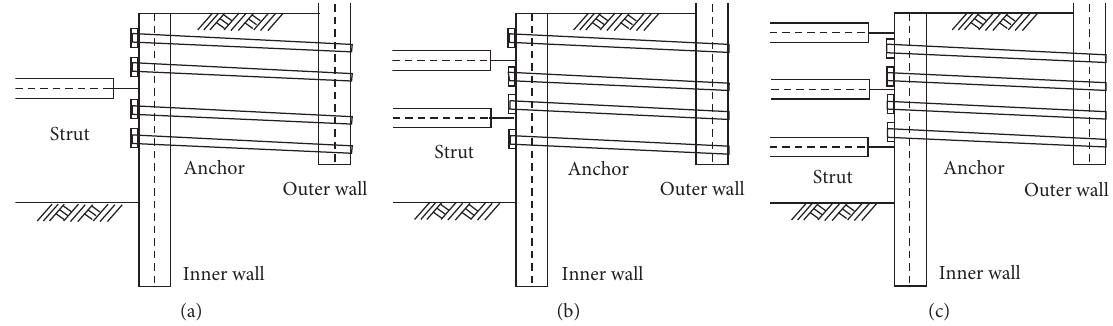
Figure 6: Structural drawing in earth stepped-twin retaining wall by constructing with anchors and struts. (a) 1 strut. (b) 2 struts. (c) 3